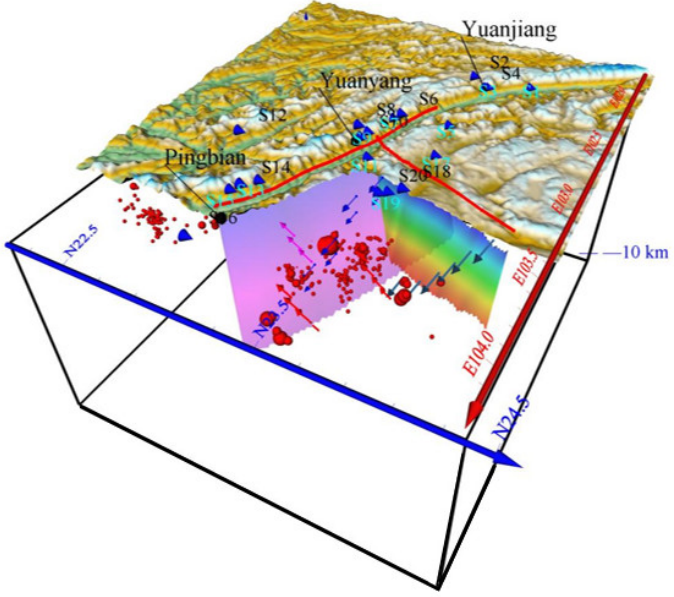
Figure 14. Circulation model of geothermal fluid at the intersection of the RRF and the